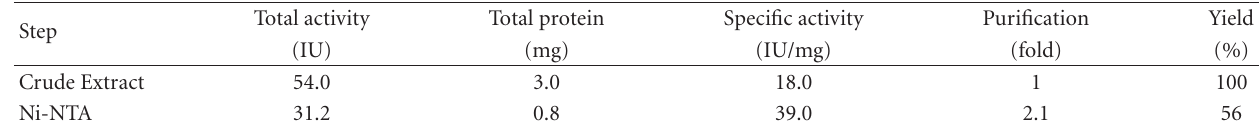
Table 1: Summary of the purification steps.